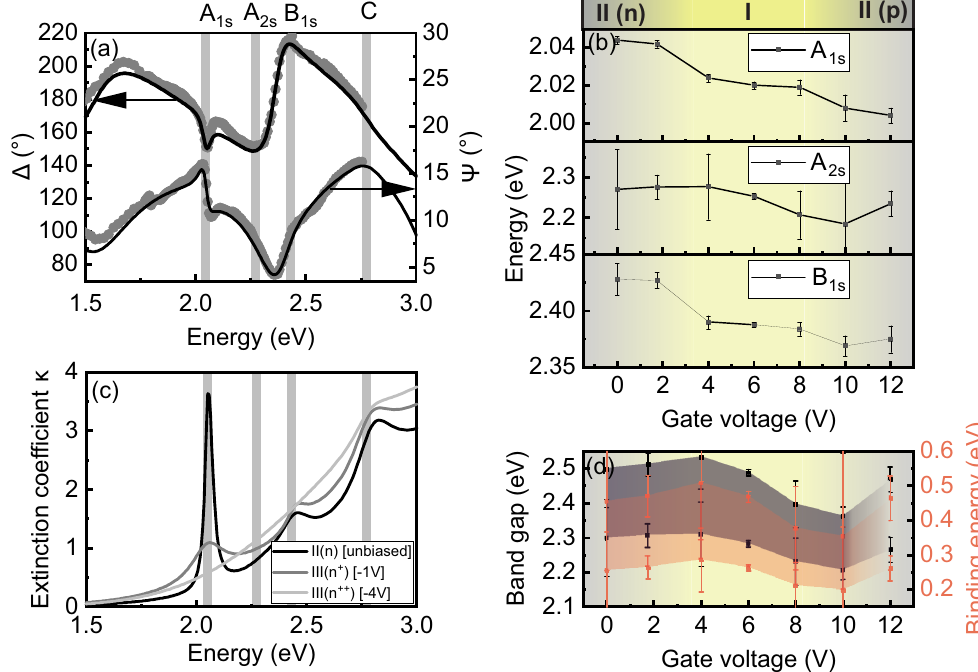
Figure 3. ( a ) Spectra of the ellipsometric angles ∆ and Ψ for WS 2 –PE gate field-effect structure for the unbiased case (symbols). Solid line represents the fit to the model from regression analysis. The excitonic signatures are indicated. ( b ) Extracted A 1 s , A 2 s and B exciton energies in dependence of positive gate voltages 0 V ≤ V g ≤ 12 V moving E F from the CB into the band gap to the VB edge. [ T = 300 K]. ( c ) Extinction coefficient κ ( E ) extracted from SIE for unbiased, V g = 1 V and V g = − 4 V corresponding to weak [II( n )], moderate [III( n + )] and high electron doping [III( n ++ )], respectively. A 1 s , A 2 s , B and C exciton signatures are indicated. ( d ) V g -dependent evolution of exciton binding energies determined from the energy difference between A 1 s and A 2 s (red) and single-particle band gap (black) considering nonlocal screening [upper and lower limit as explained in the